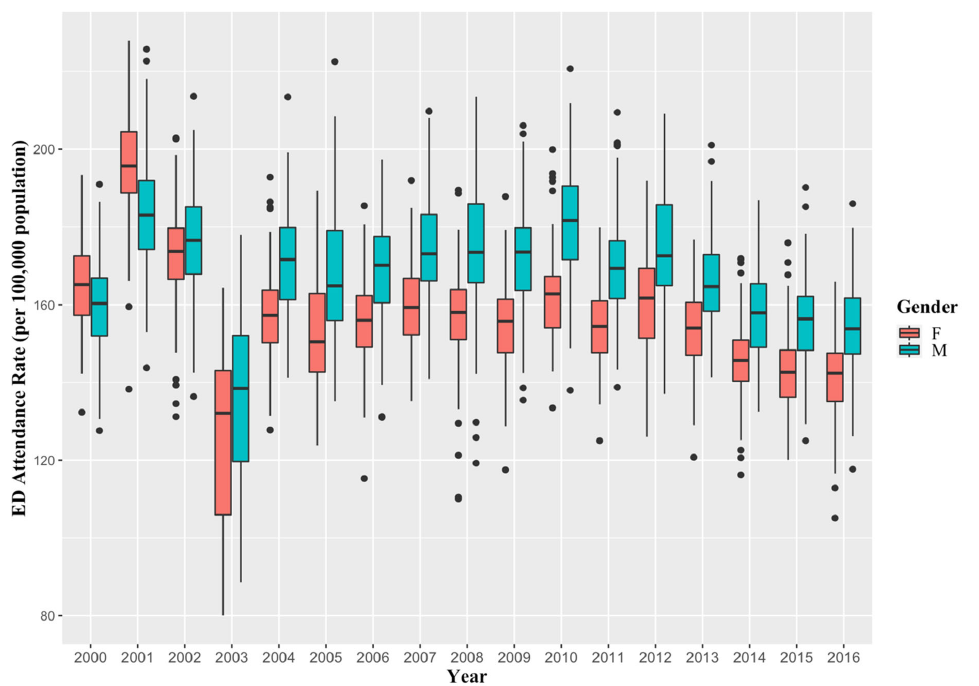
Figure 4. Distribution of daily ED attendance rate across year. Distributions are presented in form of box plots.